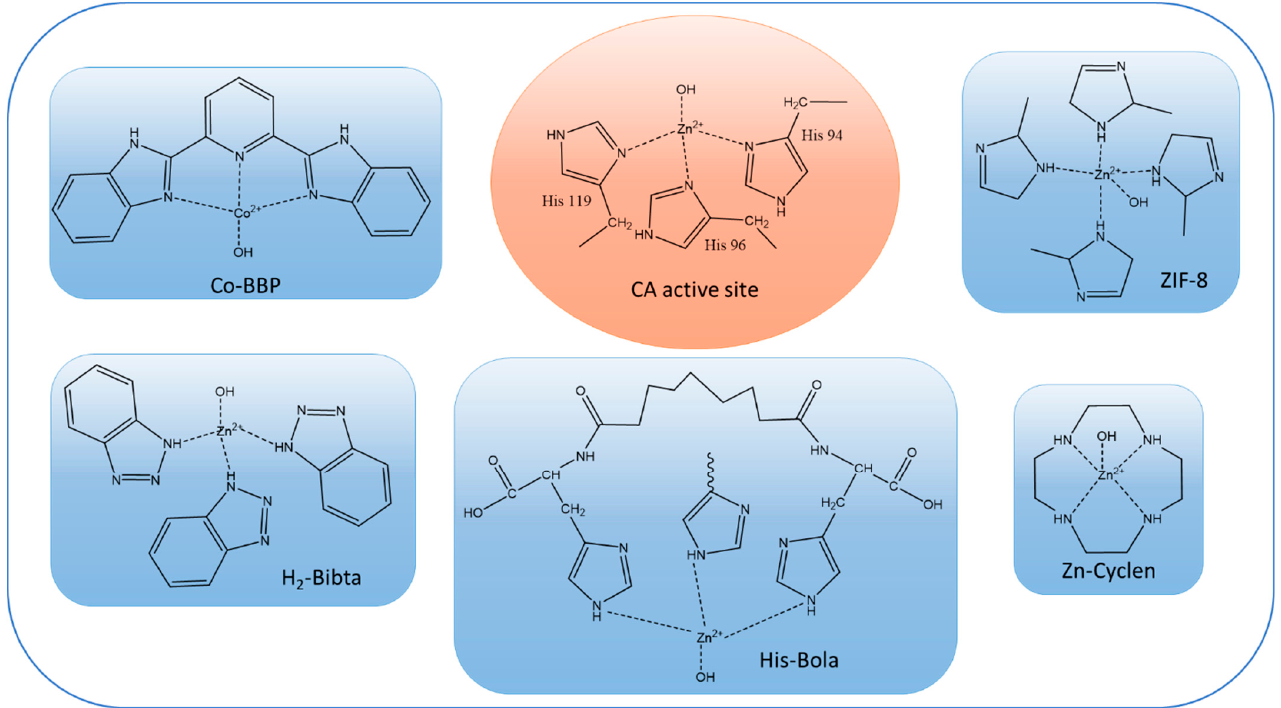
Figure 3. Chemical structures of active sites of CA enzyme (shown in orange oval) and CA-mimics (shown in blue